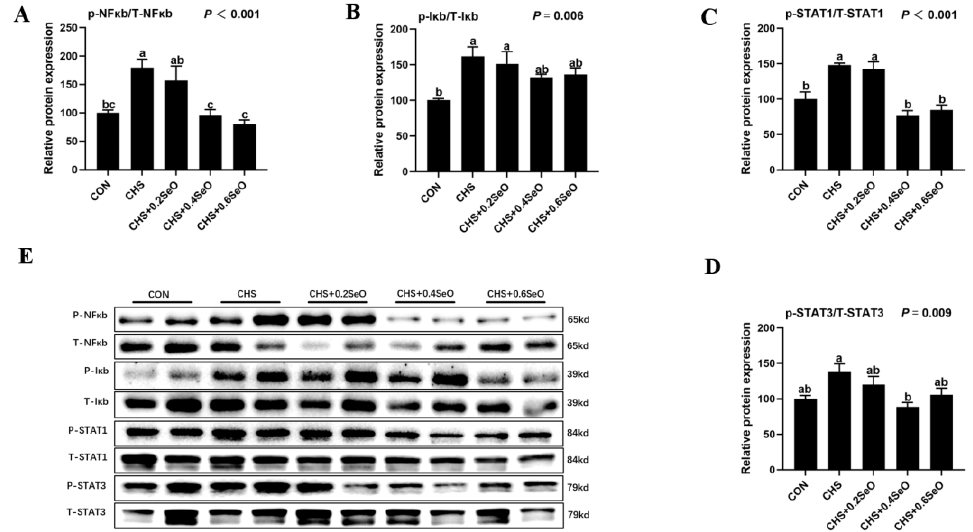
Figure 5. Effects of CHS and SeO supplementation on the abundance of protein related to NFκb and STAT signal in the spleen. ( A – D ) Relative protein expression level, ( E ) Relevant protein bands. The results were expressed as mean ± SEM ( n = 6). Different letters (a, b and c) denote significant differences ( p < 0.05).